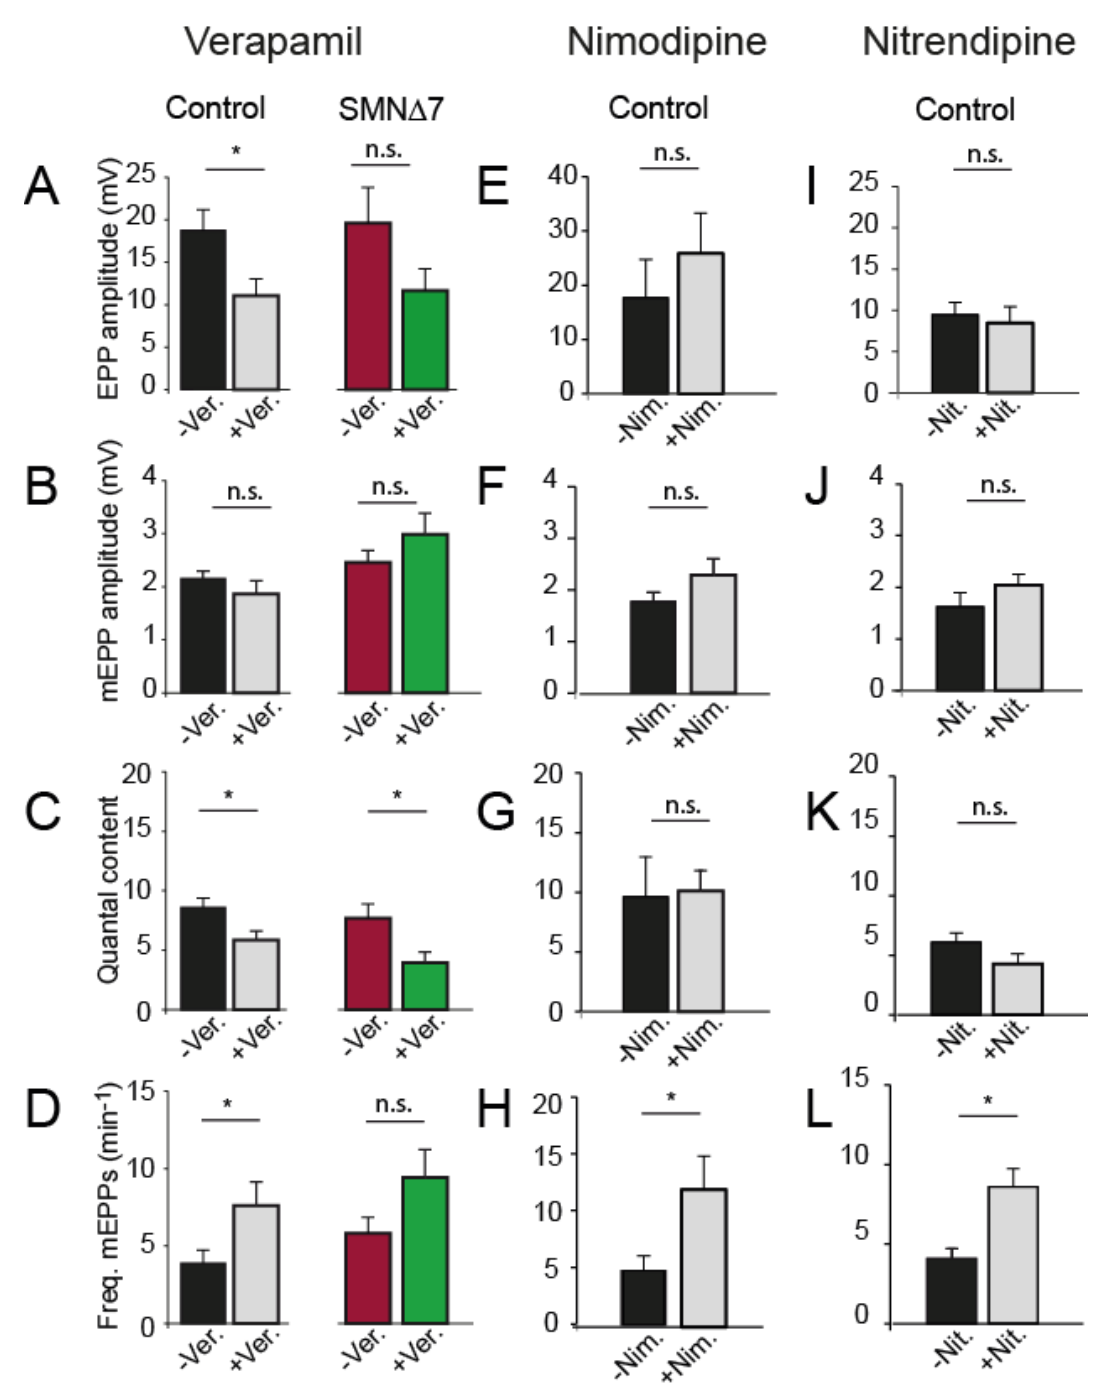
Figure 3. Nifedipine increases neurotransmission independently of its blocking effect on Ca 2+ entry through L-type Ca 2+ channels in postnatal mice. ( A – D ) Effect of verapamil (Ver., 3 µM), ( E–H ) nimodipine (Nim., 10 µM), and ( I–L ) nitrendipine (Nit., 50 µM) on EPP size ( A,E,I ), mEPP size ( B,F,J ), quantal content ( m ) ( C, G, K ), and mEPP frequency ( D,H,L ) in control terminals, except for verapamil that was also tested in SMA terminals (* p < 0.05; two-tailed Student’s t -test). 2.4. Nifedipine Increases the RRP Size in Controls but Not in SMA Terminals Since nifedipine potentiated secretion at low-frequency stimulation in both genotypes, we also examined whether this drug increases neurotransmission during high-frequency nerve stimulation (20 Hz trains of 5 s duration) in control and SMA motor nerve